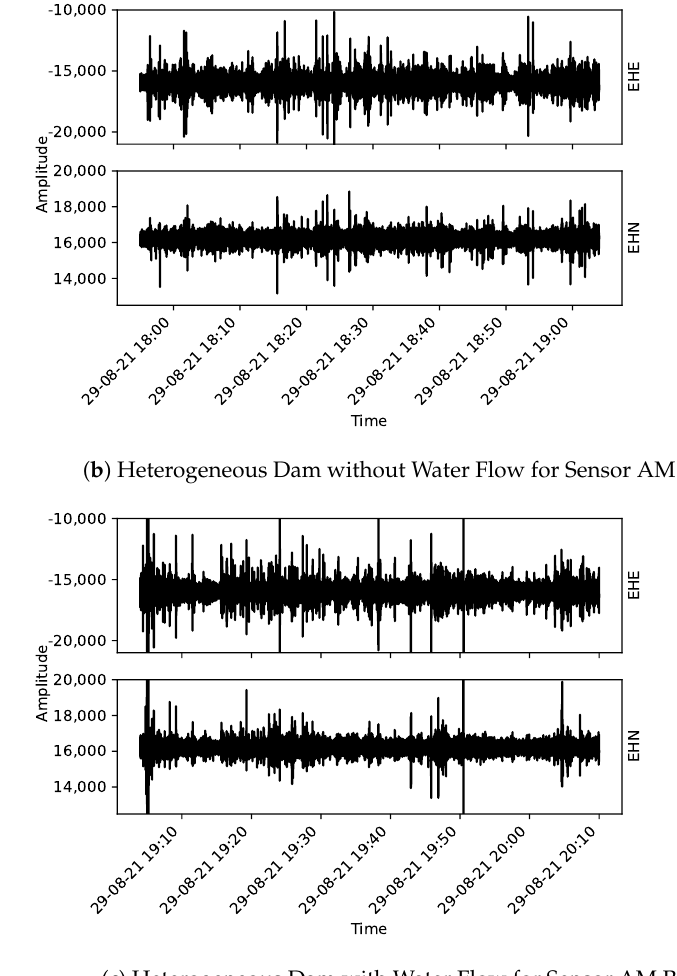
( a ) Homogeneous Dam for Sensor AM.R7D9F.